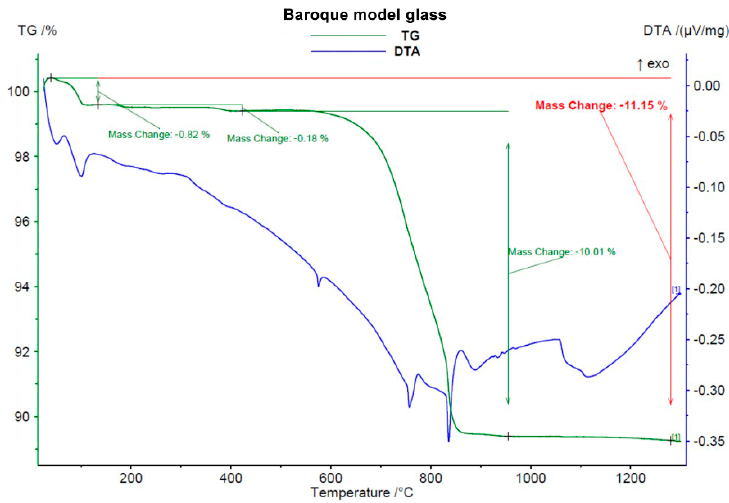
Figure 3. Course of DTA-TG analysis of Baroque model glass.